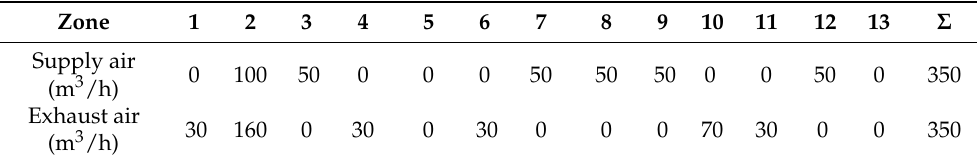
Table 11. Air flows in the mechanical ventilation